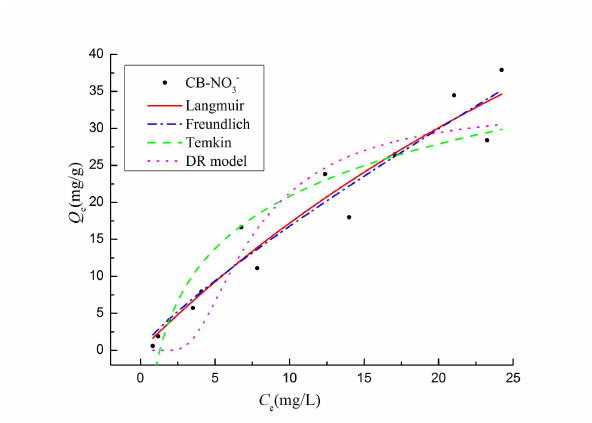
Figure 8. The isotherm adsorption of CB biochar for NO 3 − (650 ◦ C / 3 h).